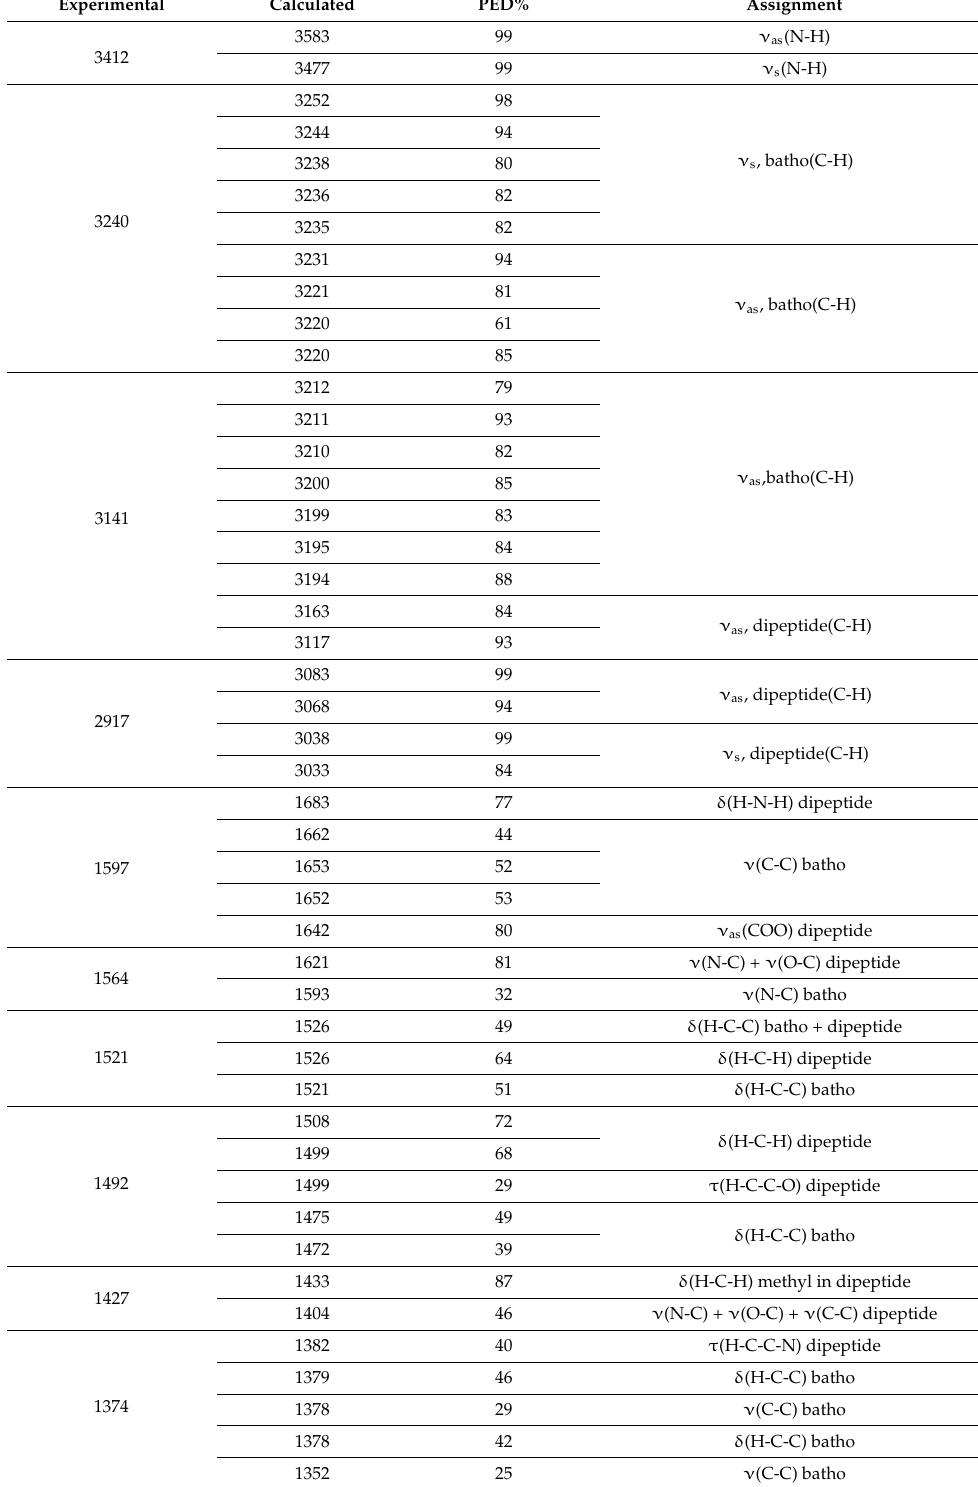
corresponding frequencies of selected vibrational modes are shown in Table 1. For clarity purposes, the vibrational modes for bonds are discriminated by ligand (batho and dipeptide). Table 1. Experimental band assignment using PED for 3 . Experimental and calculated frequencies are expressed in cm − 1 . Experimental Calculated